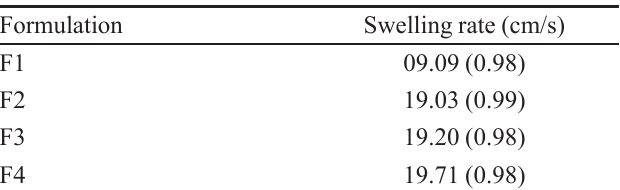
TABLE III - Swelling rates of Sodium alginate and modified SA beads Formulation Swelling rate (cm/s)